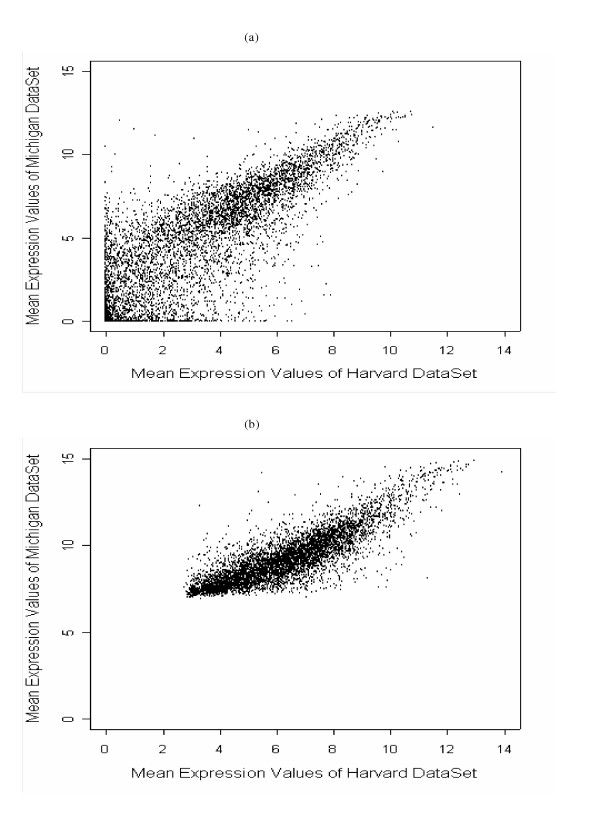
Scatter plots of (a) quality-weighted and (b) quality-unweighted mean expression values for the 6124 common probe sets in the Harvard and Michigan datasets based on normal (healthy) samples.